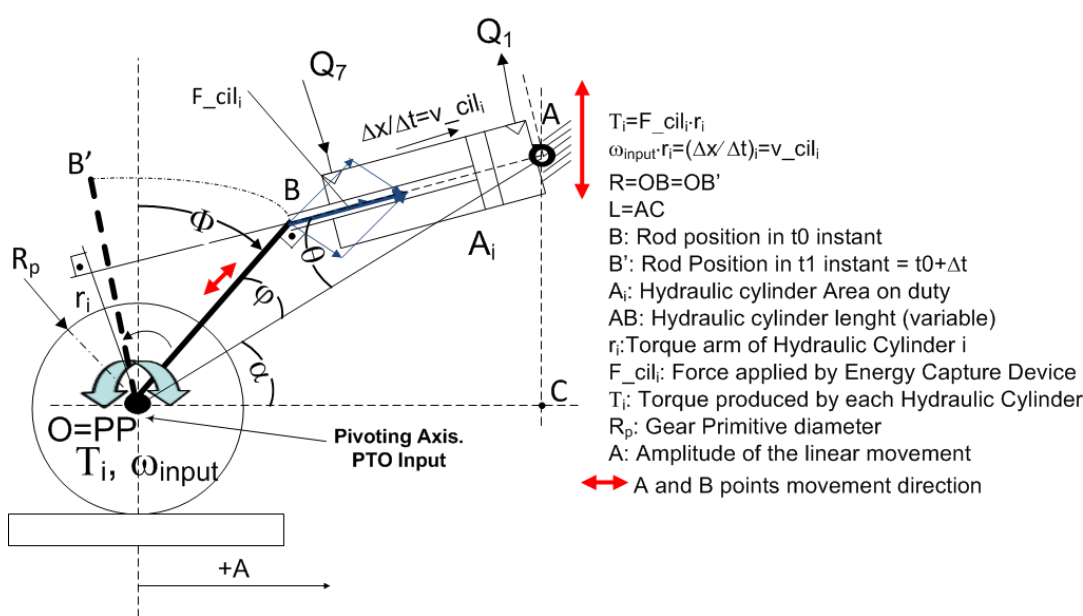
Figure 2. Parameters defining the position of one of the hydraulic cylinder rod with respect to the pivoting axis